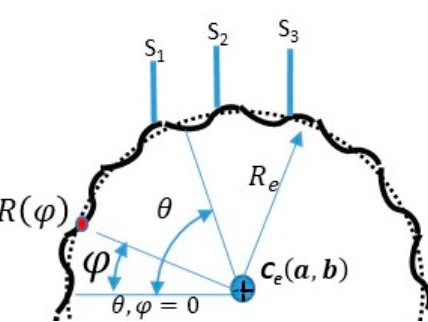
Figure 8. Perturbation of the inspected part.